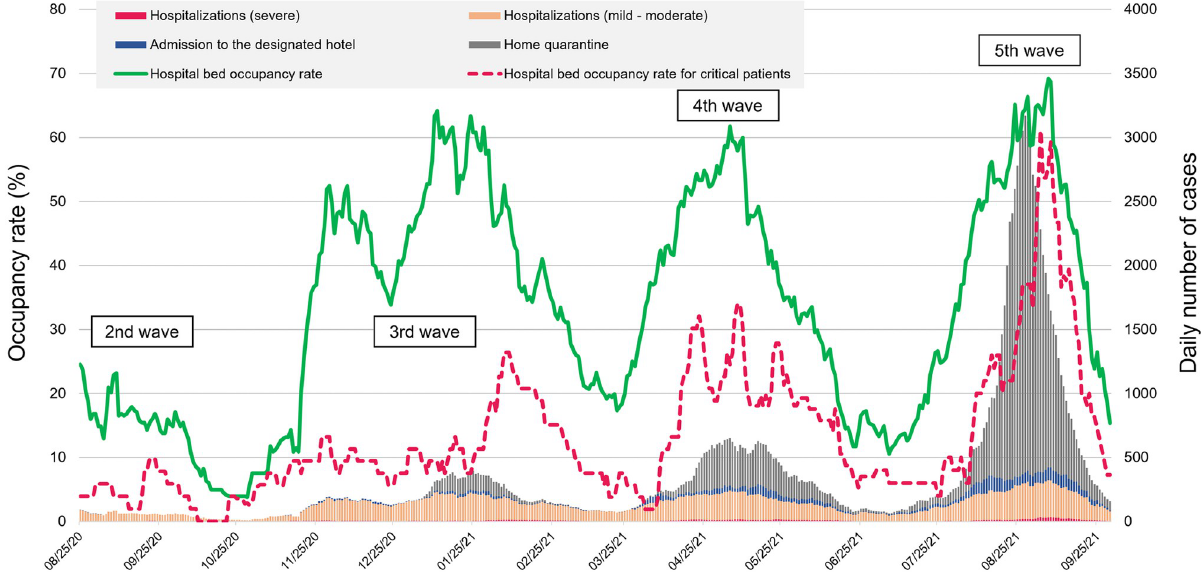
Fig 2. Changes in the number of COVID-19-infected persons, those who were quarantined in their own home or admitted to the designated hotel, and the hospital bed occupancy rate in Mie